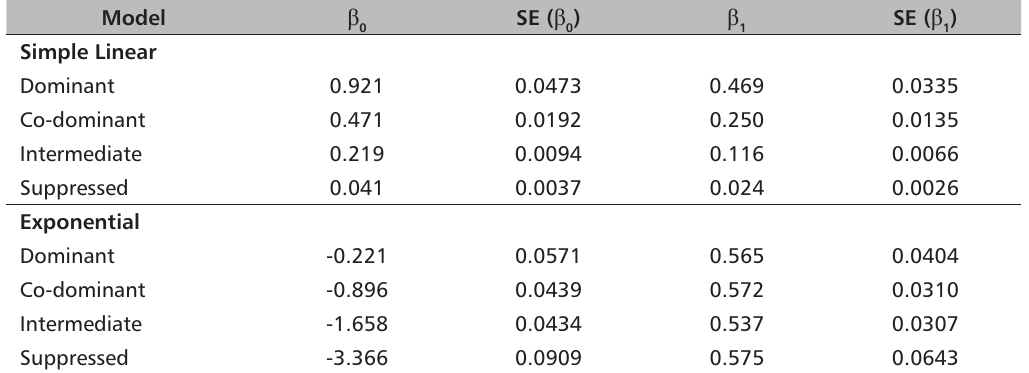
TABLE 3. Estimates of model coefficients and standard errors (SE) of the fixed